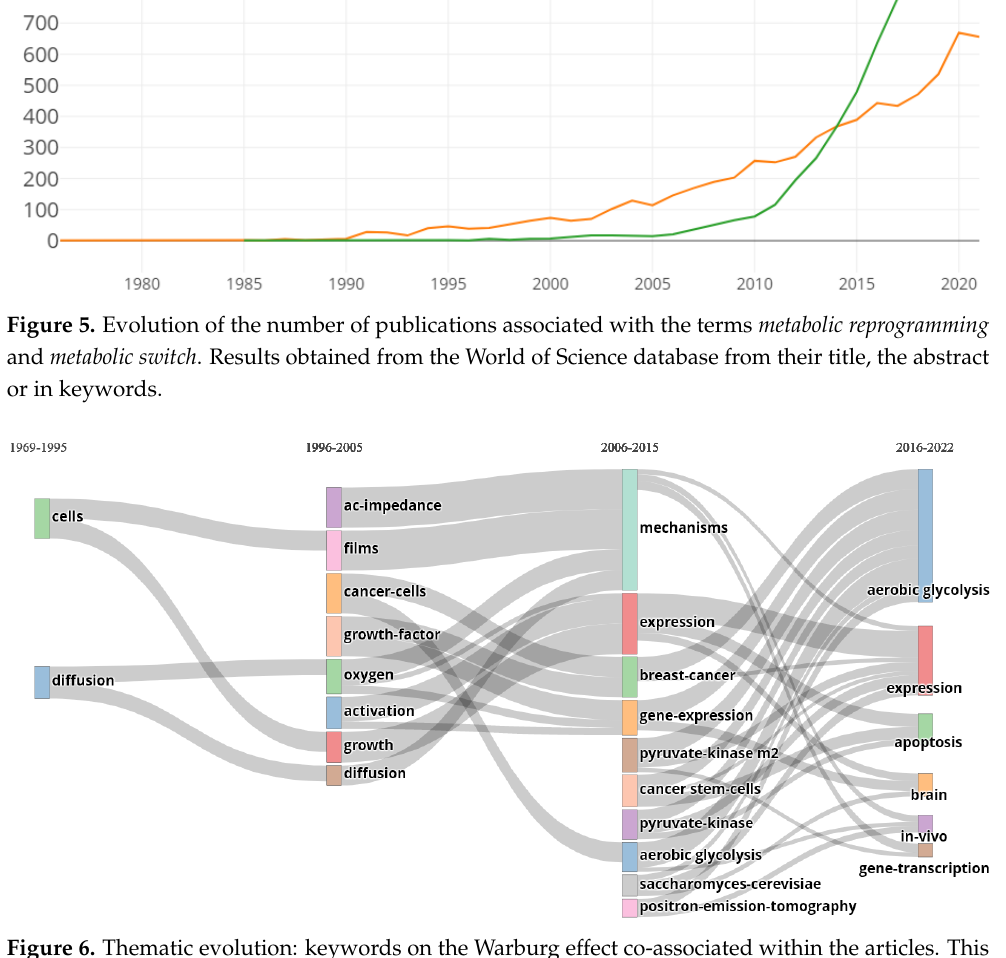
Figure 6. Thematic evolution: keywords on the Warburg effect co-associated within the articles. This Sankey diagram was generated with the R package bibliometrix (version 3.2.1) on 3128 documents extracted from the World of Science database, for articles dating from 1969 to 2022, and including the term “Warburg effect” in the title, the abstract or in keywords. Three dates (1995–2005–2015) were chosen to segment the